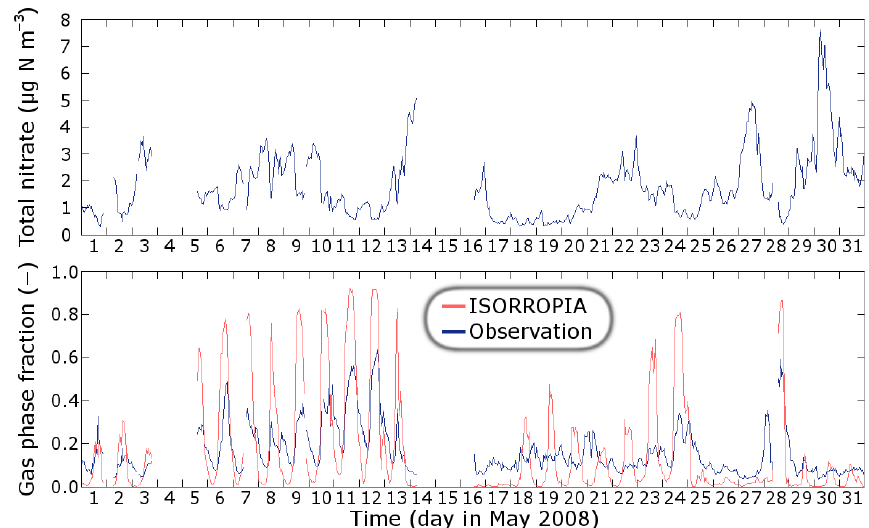
Fig. 1. Upper panel: observed total nitrate (nitric acid plus aerosol nitrate) concentration at Cabauw for May 2008. Lower panel: observed partitioning of nitrate and equilibrium by ISORROPIA for May 2008. Gaps in the graphs are caused by missing